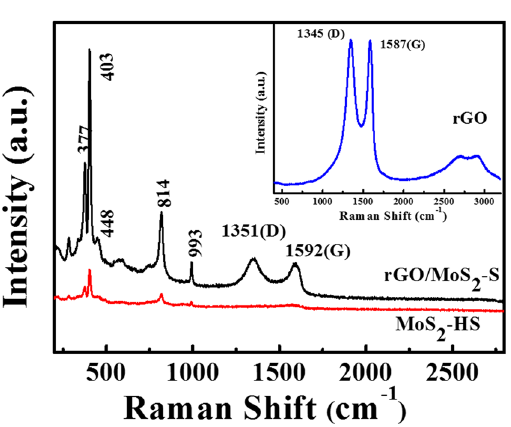
Figure 5. The Raman Spectra of MoS 2 -HS and rGO/MoS 2 -S